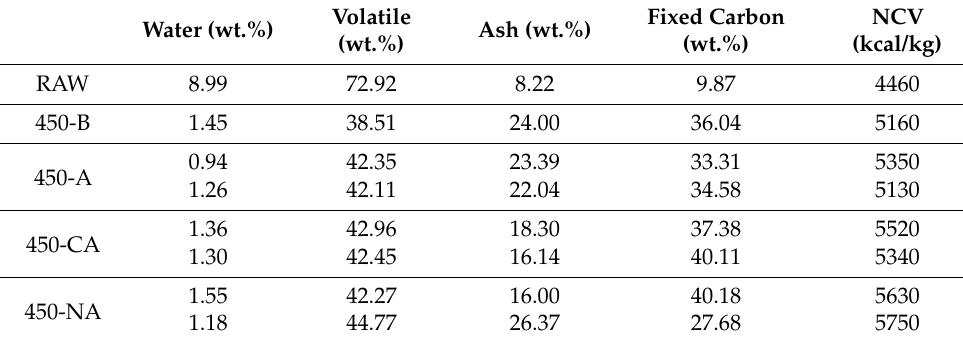
Table 1. A proximate and calorific value analysis of raw food waste feedstuff and pyrolyzed biochar with different demineralization